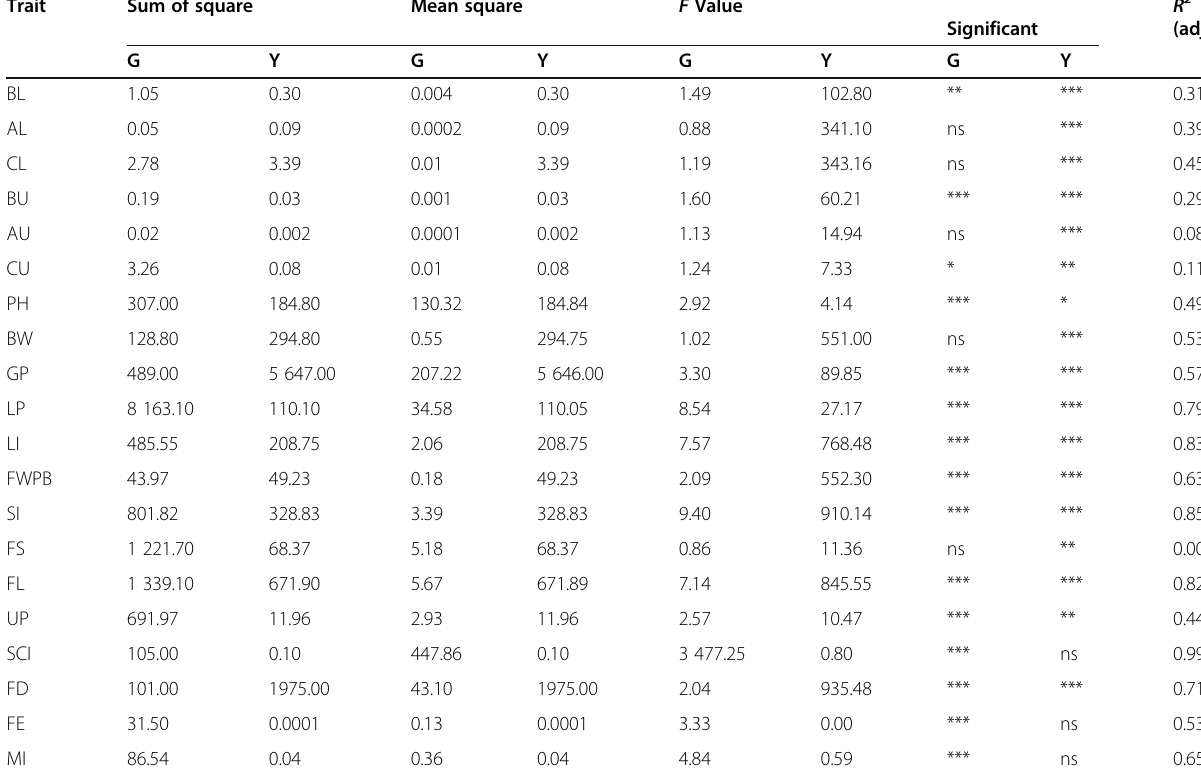
Table 1 ANOVA for 20 traits in 2017 and 2018 Trait Sum of square Mean square F